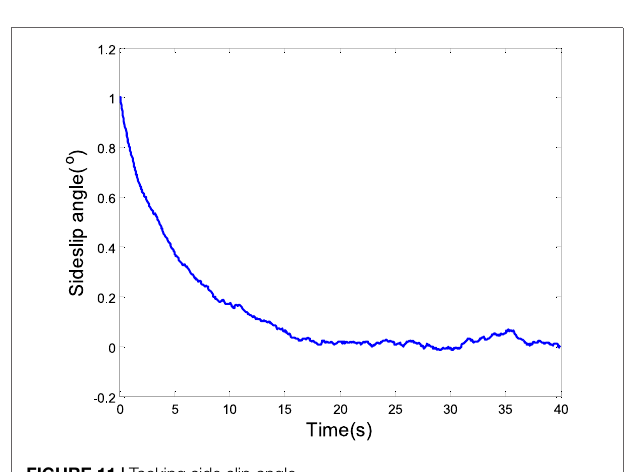
FIGURE 10 | Tracking attack angle.